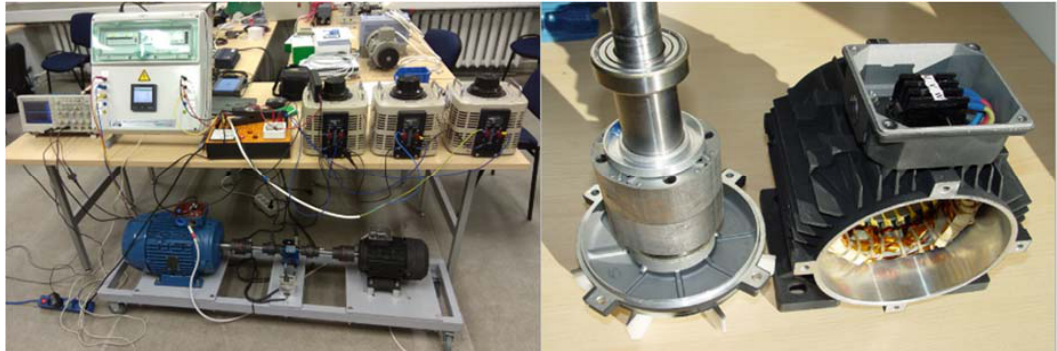
Figure 3. ( a ) The overall view of test bench of experiments with PMSM; ( b ) tested PMSM with rotor and stator